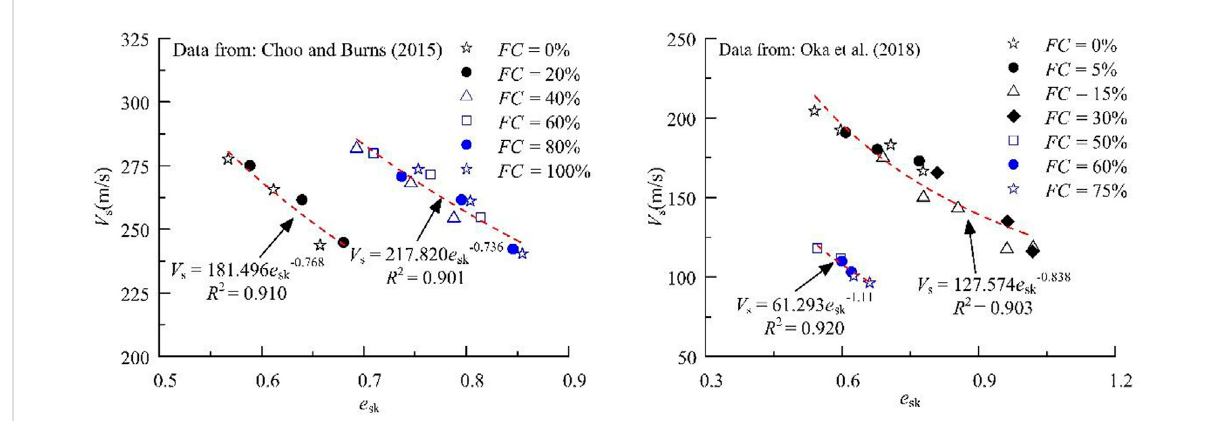
FIGURE 10 Relationship between V s and e sk for two types of coarse and fi ne granular mixtures obtained from the